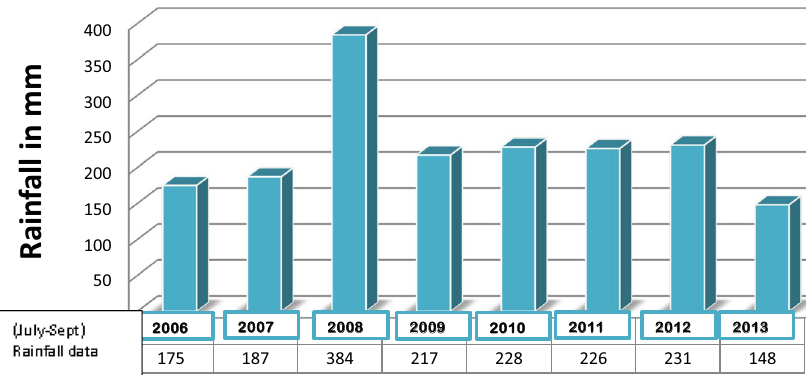
Fig. 2 Average rainfall